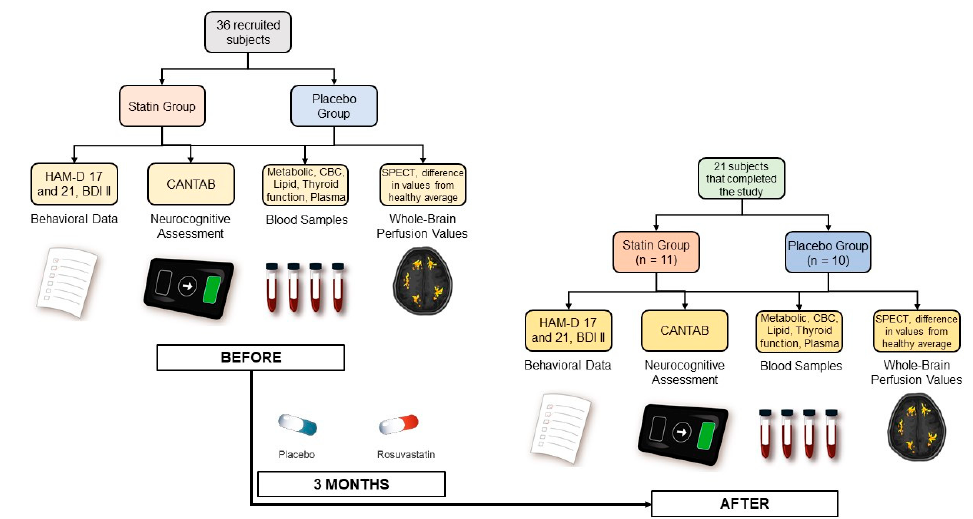
Figure 1. Experimental procedure for data collection.